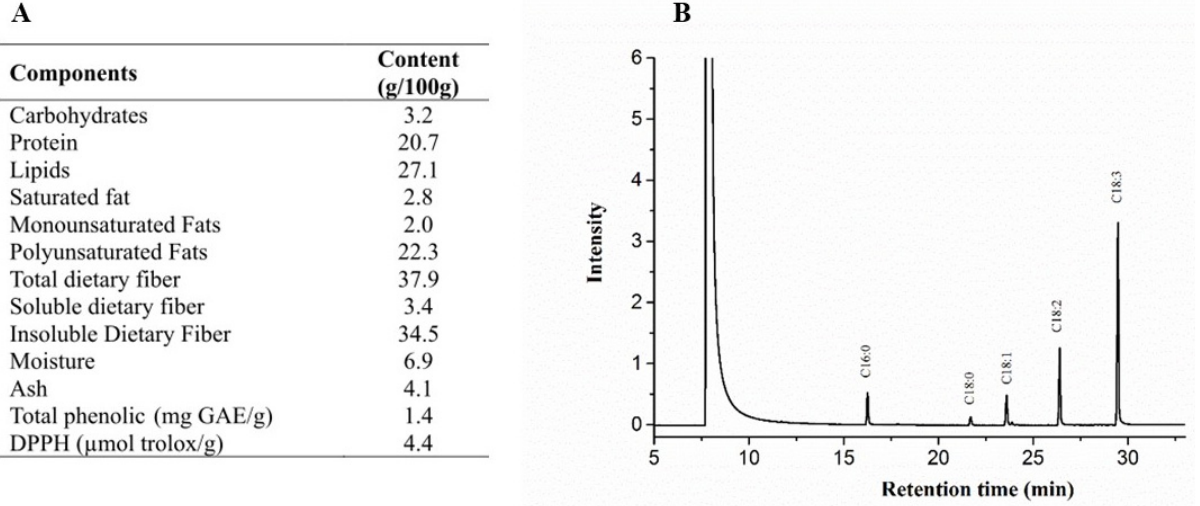
Figure 2. ( A ) Chemical characterization of chia flour. ( B ) Chia oil chromatogram with identification of fatty acids: P1: palmitic acid (C16:0, 7.6%); P2: stearic acid (C18:0, 2.7%); P3: oleic acid (C18:1, 7.5%); P4: linoleic acid (C18:2, 19.9%); and P5: alpha linolenic acid (C18:3, 62.3%). In total, 10.3% of fatty acids are saturated, 7.5% monounsaturated, and 82.2% polyunsaturated.